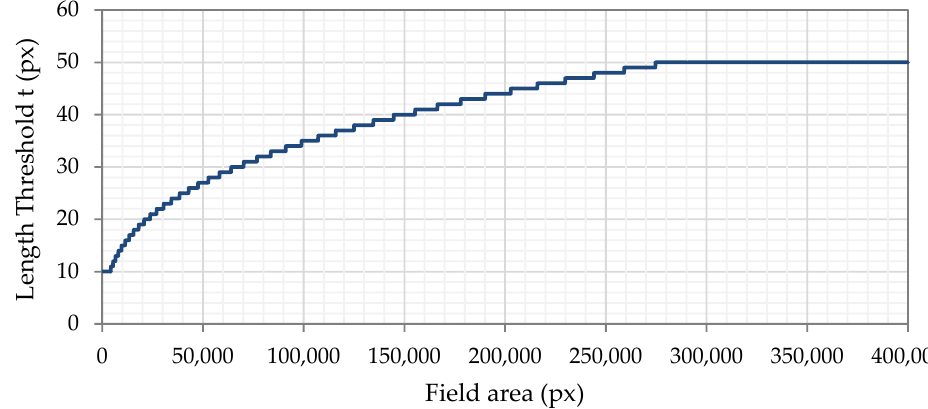
Land 2021 , 10 , x FOR PEER REVIEW Figure 16. Calculation of Length Threshold t depending on the field area. Figure 16. Calculation of Length Threshold t depending on the field area.